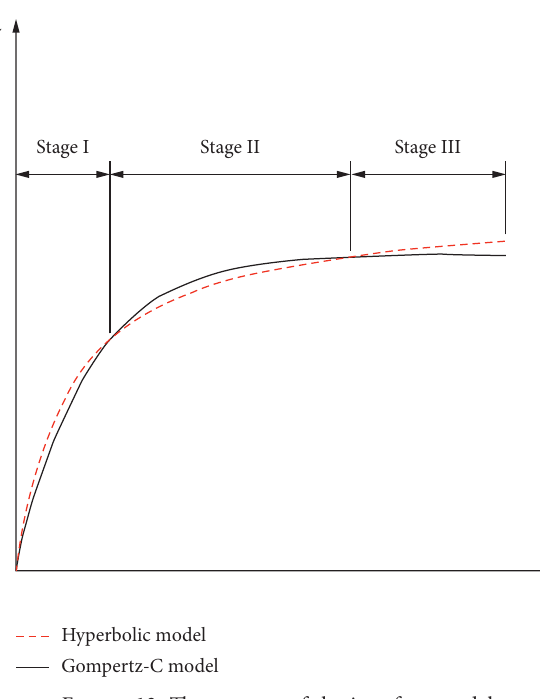
Figure 12: Three stages of the interface